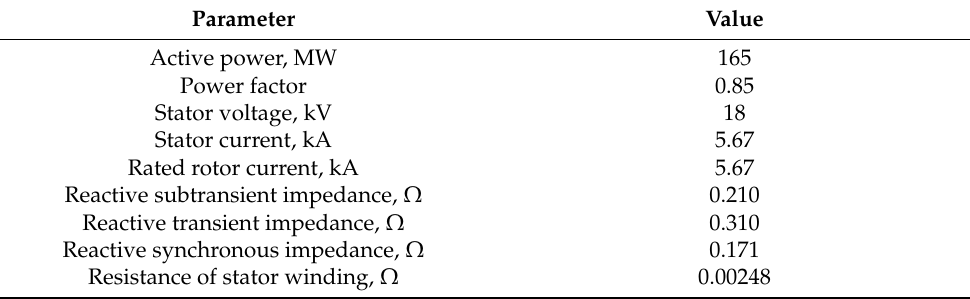
Figure 7. Single-line diagram of the power plant under consideration. Figure 7. Single ‐ line diagram of the power plant under consideration. According to the single-line diagram of the power plant, generators 8–10 operate at The rated parameters of the generators are shown in Table 3. one bus of rated voltage 330 kV (tie circuit breaker is switched on), and generators 6 and 7 are separated from the others by autotransformers at 330/110 kV, respectively. All power Table 3. Rated parameters of generators. units have the same transformers. All generators have the same equipment, including the exciter and AVR. It should be noted that regulator settings were set separately in order to create the possibility of a situation when settings may vary during the disturbance. The rated parameters of the generators are shown in Table 3. Table 3. Rated parameters of